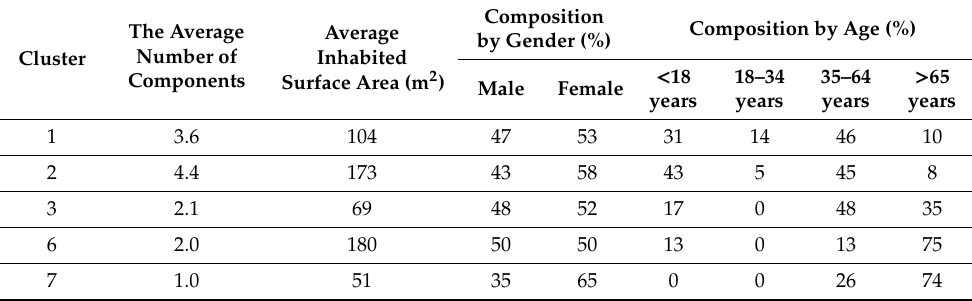
Table 5. Sociodemographic characterization of the clusters.